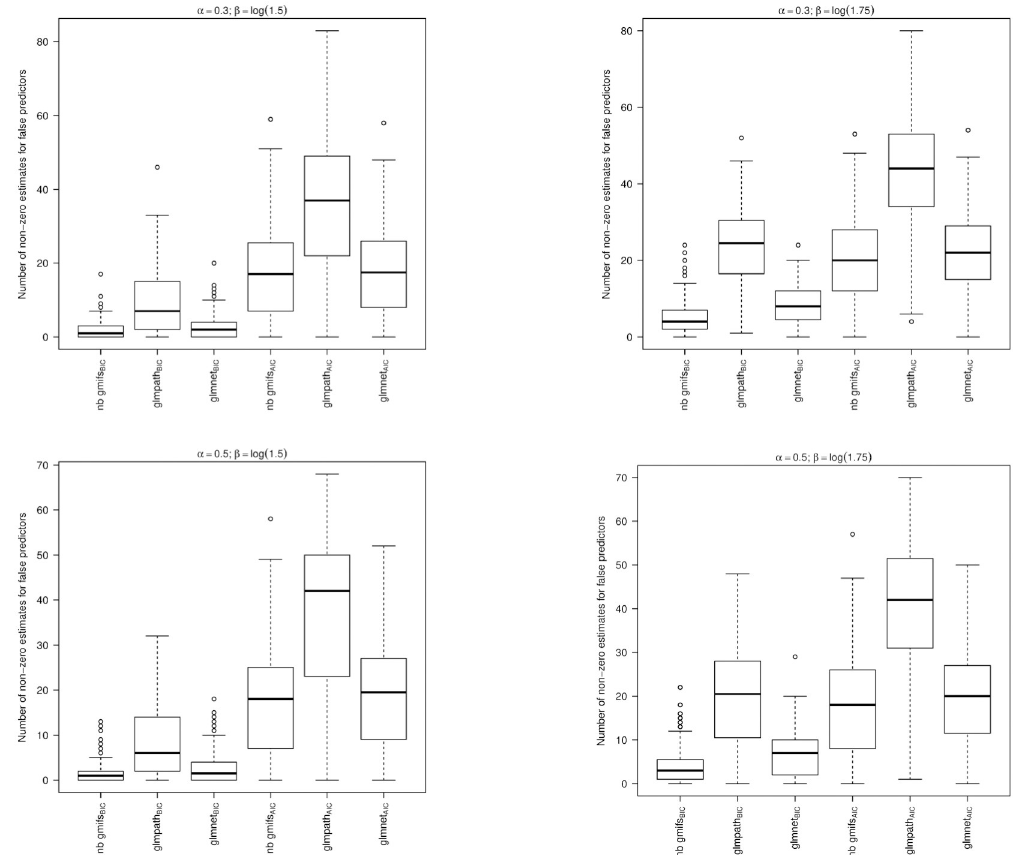
Fig 4. For each modeling method, number of false predictors that had a non-zero coefficient estimate (Oracle = 495). A: α = 0.3; β = ± log(1.5). B: α = 0.3; β = ± log(1.75). C: α = 0.5; β = ± log(1.5). D: α = 0.5; β = ±